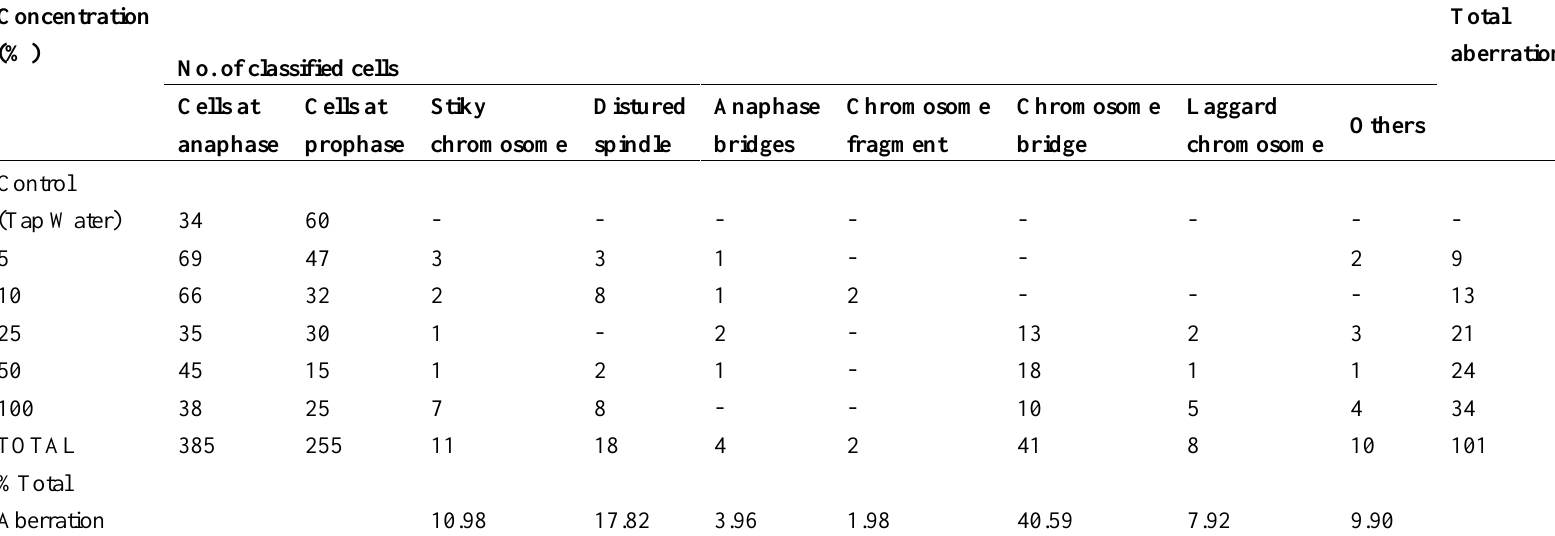
Table 3. Chromosomal aberrations in Allium cepa cells treated with different concentrations of e-waste